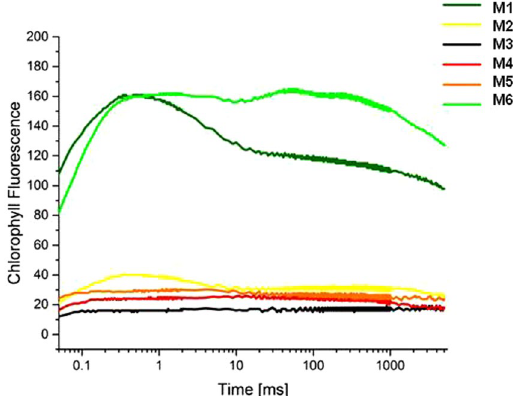
Figure 3. Fluorescence induction curves indicating the kinetics of the light reaction of the six moss samples. The Y axis indicates the chlorophyll fluorescence emission as radiometric quantification. Legend: M1-M6 indicate the sample numbers (1–6) as reported in Table